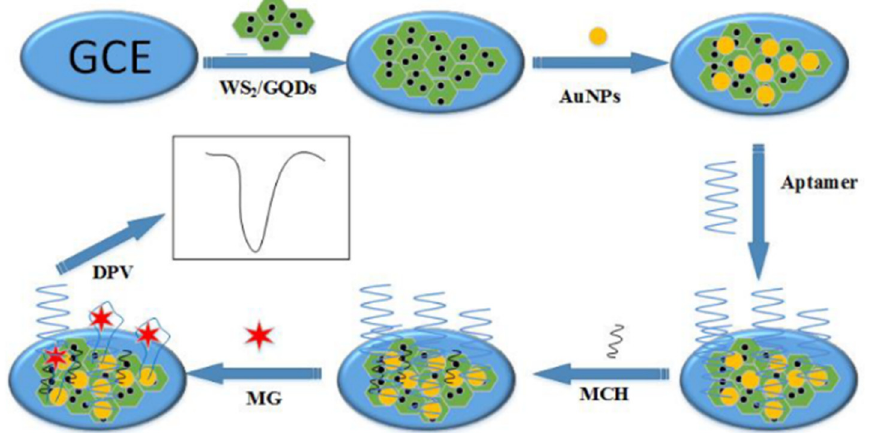
Figure 10. Procedure for fabrication of aptasensor receptor layer for label-free detection of malachite green. Adapted with permission from Wang et al. [87] (under the terms and conditions of the Creative Commons CC BY License 4.0).